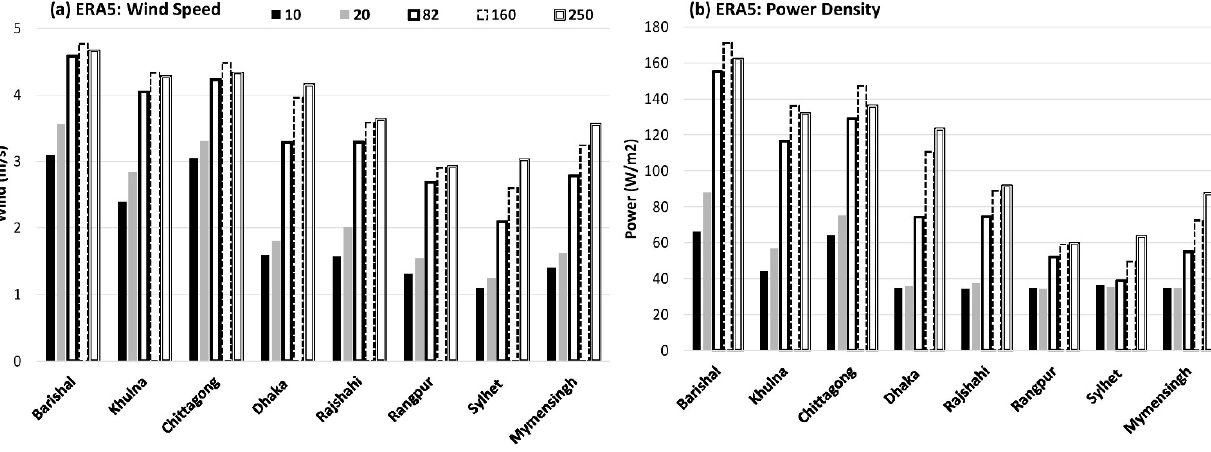
Figure 7. Same as in Figure 6 but valid for ERA5 ( a ) average wind speed (1979 to 2018) and for Polynomial ( b ) power density.